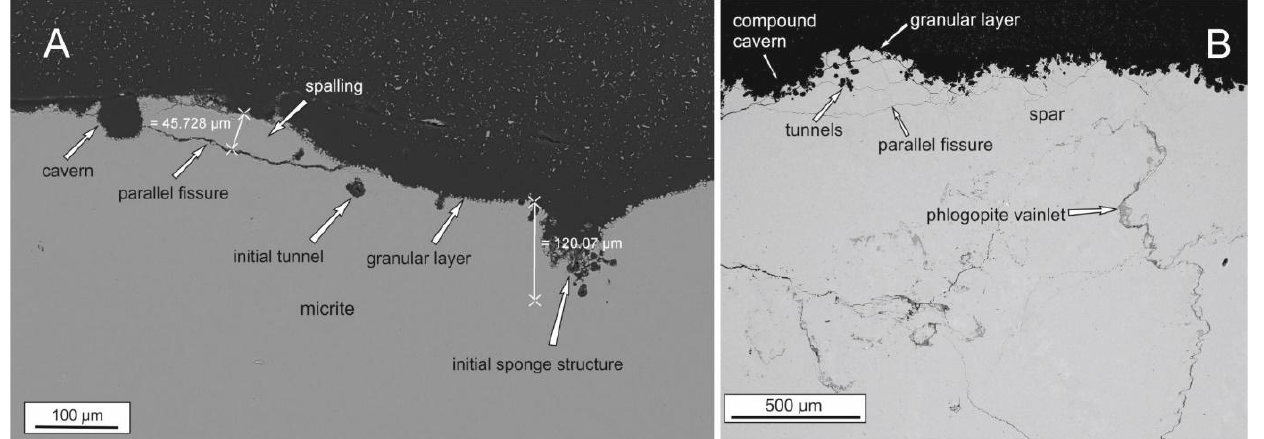
Figure 13 . Weathering rind at site 3 (subject to the weathering for 50–51 years); ( A )—single cavern and initial sponge structure developed in micrite; ( B )—deep fissures filled with phlogopite, a compound cavern with initial sponge structure in spar (images from FE-SEM).